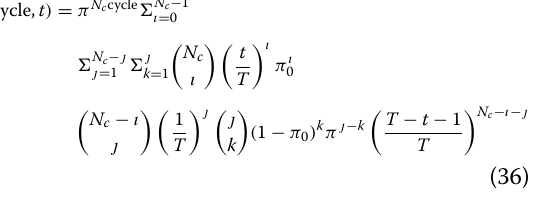
The successful transmission probability P suc could be similar as the obtained probability of collision P col as long as the channel is free for cycle cycles and t